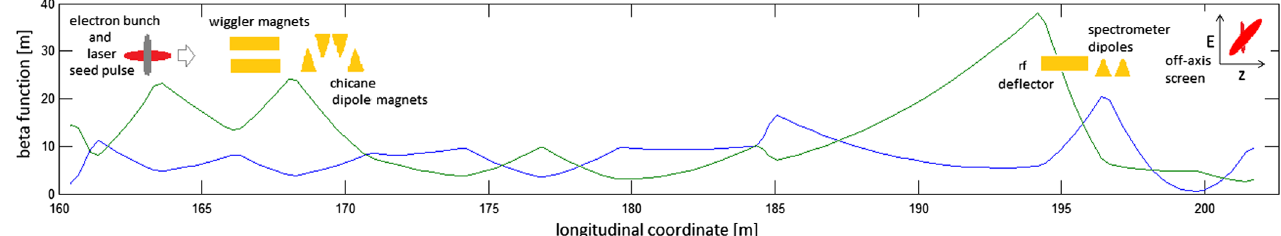
FIG. 3. Experimental setup at FLASH. An electron beam is overlapped with a seed laser pulse and sent through an undulator magnet, imparting a sinusoidal energy modulation with a period given by the laser wavelength. This seeded beam is sent through a chicane followed by a 25 m stretch of beam line with variable-gap undulators. The longitudinal phase-space distribution is then measured with an rf deflector which streaks out the longitudinal dimension of the bunch and spectrometer dipole magnets which deflect the electrons depending on their energies. The electron bunch on the off-axis screen is depicted with a longitudinal energy chirp (diagonal) and a superimposed energy modulation (vertical).